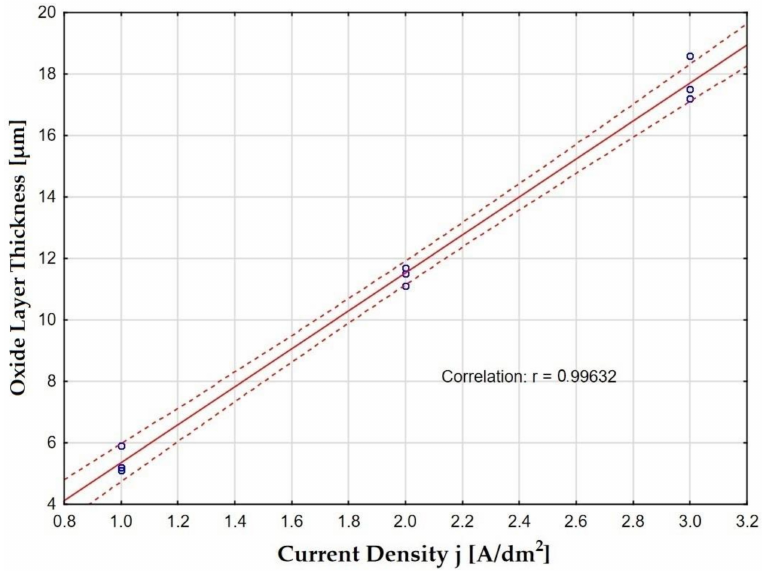
Figure 6. Effect of current density on layer thickness, along with the confidence